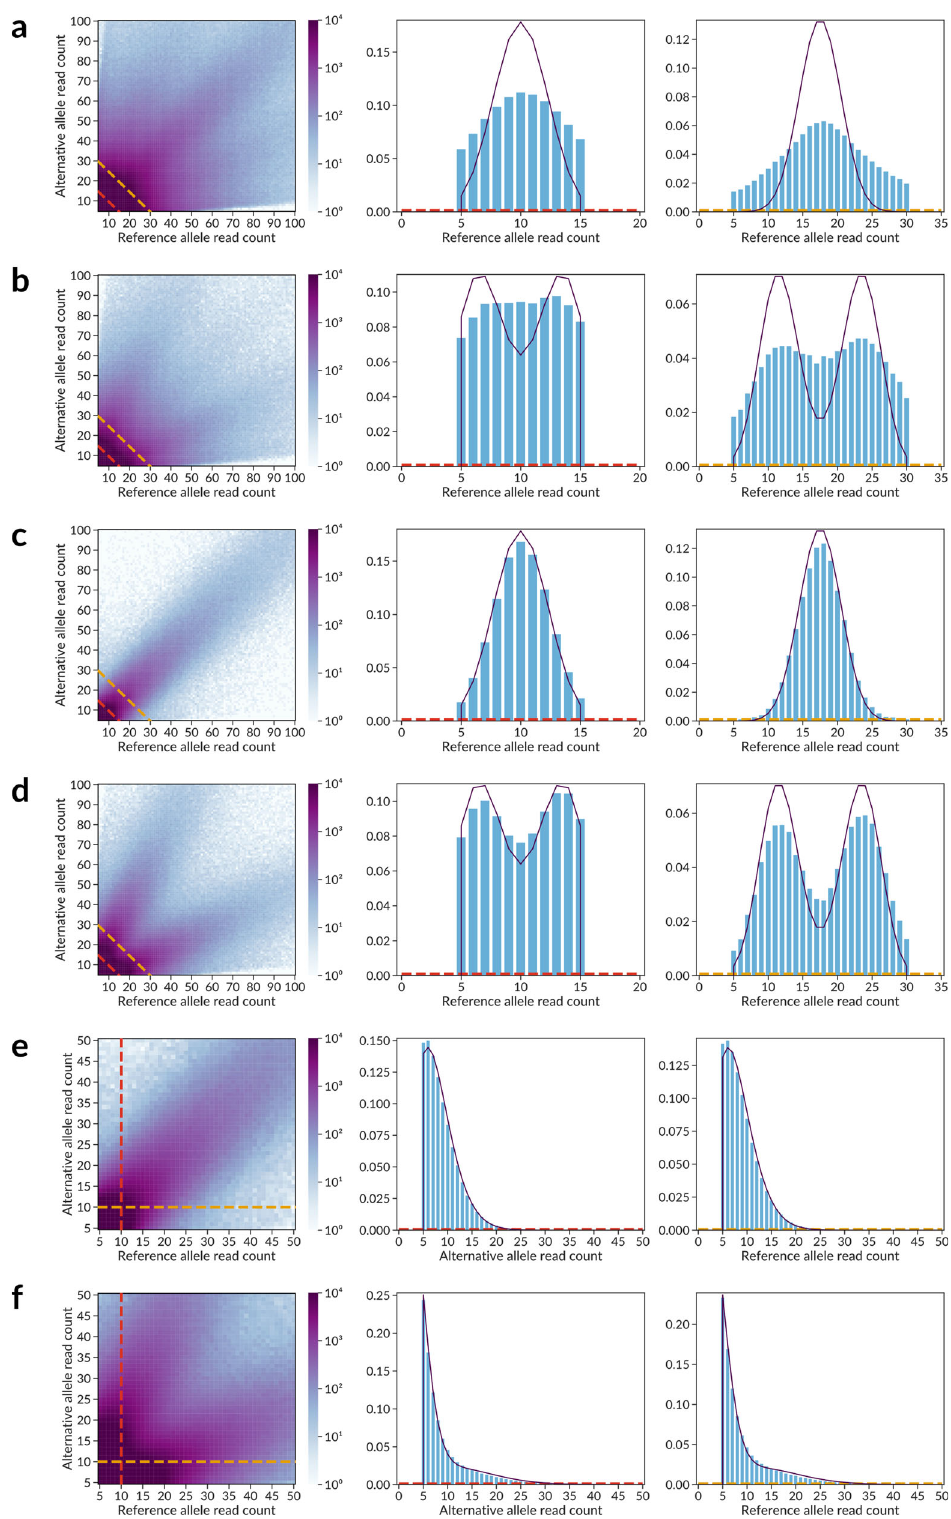
where p and 1 − p were fi xed to re fl ect the expected frequencies of allelic reads, namely, 1/(BAD + 1) and BAD/(BAD + 1). The parameters r (number of failures) and w (weights of distributions in the mixture) were fi tted with L-BFGS-B algorithm from scipy.optimize 59 package to maximize the model likelihood iteratively with boundaries r > 0 and 0 ≤ w ≤ 1, assigning initial values of r = m (number of reads on the fi xed allele) and w = 0.5, respectively. A is the normalization coef fi cient (necessary due to truncation) corresponding to allelic reads cutoff of 5. The goodness of fi t was assessed by root mean square error